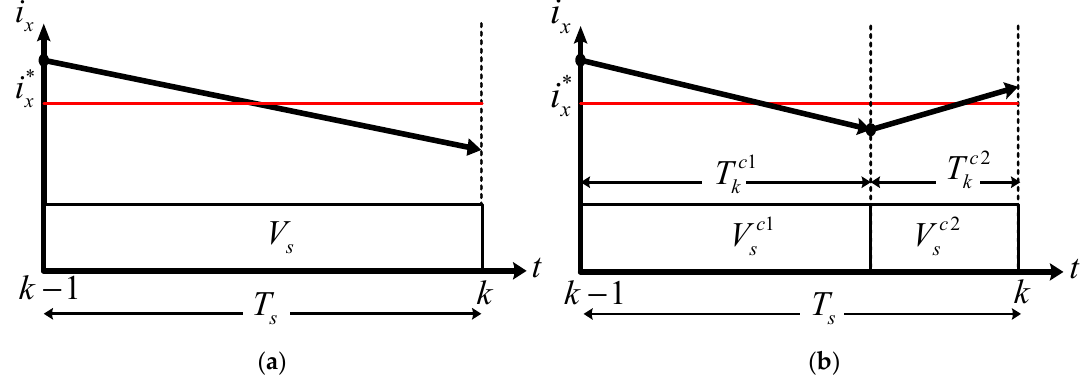
Figure 4. Applied voltage vectors in a typical sampling period: ( a ) conventional MPCC without modulation; ( b ) the proposed MMPCC.